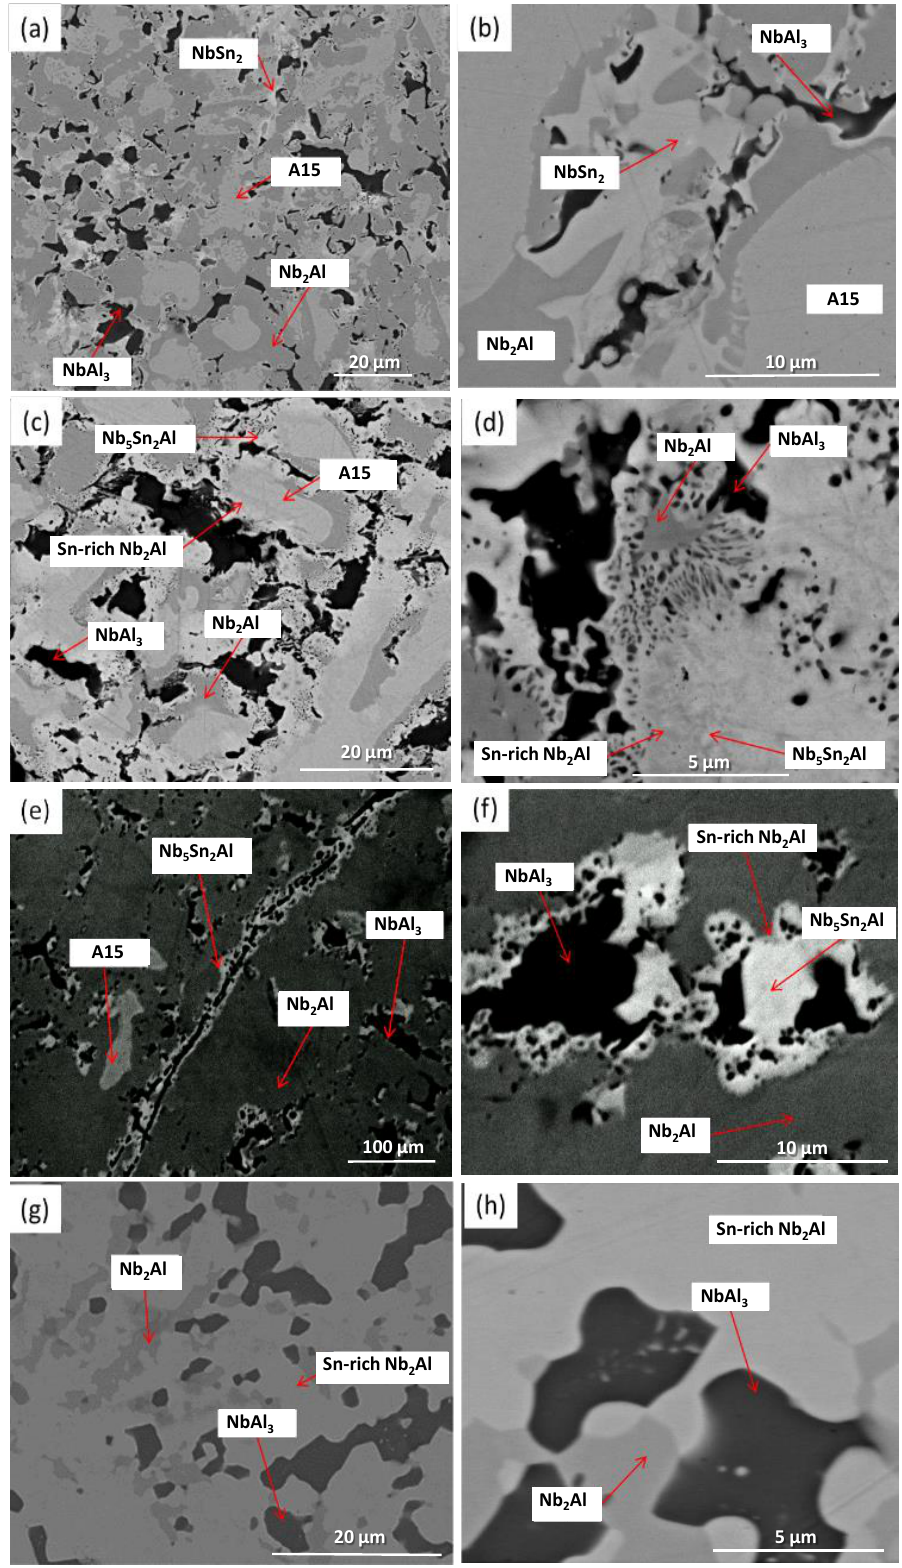
Figure 5. BSE images of ( a , b ) IP5-AC, ( c , d ) IP5-HT-900 °C/100 h, ( e , f ) IP5-HT-900 °C/300 h and ( g , h ) IP5-HT-1200 °C/100 h.